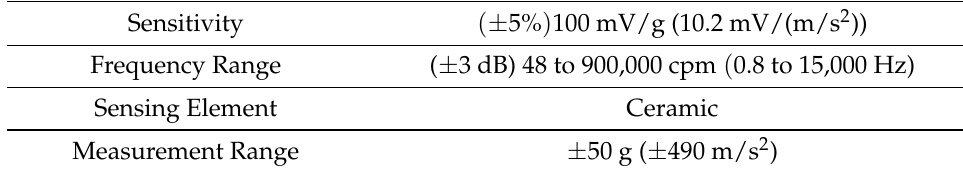
Table 2. The Piezo-accelerometer IMI 623C01